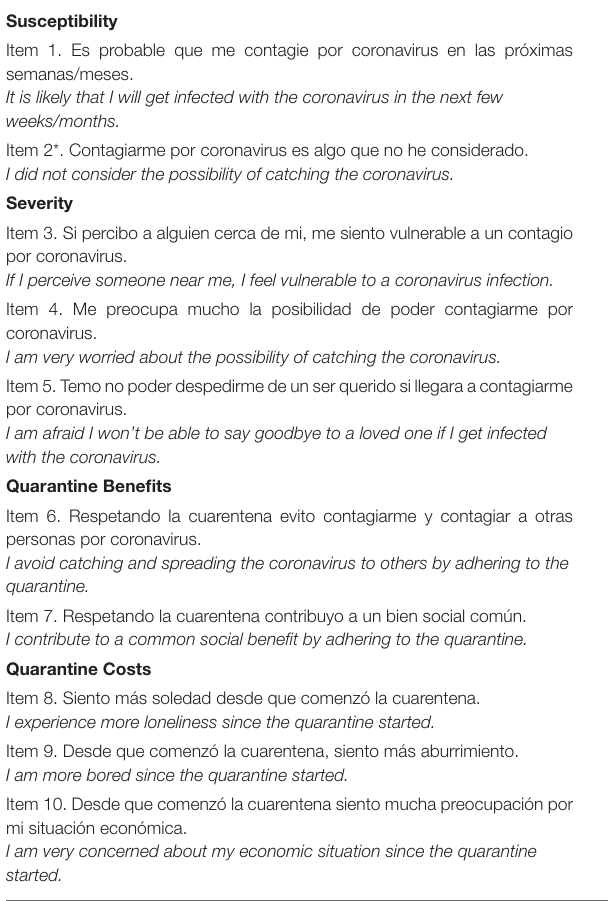
TABLE 2 | Items of the HBM questionnaire used in the